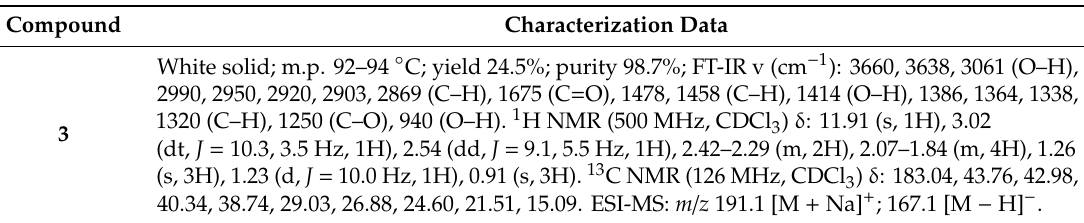
Table 3. Characterization data of myrtanyl